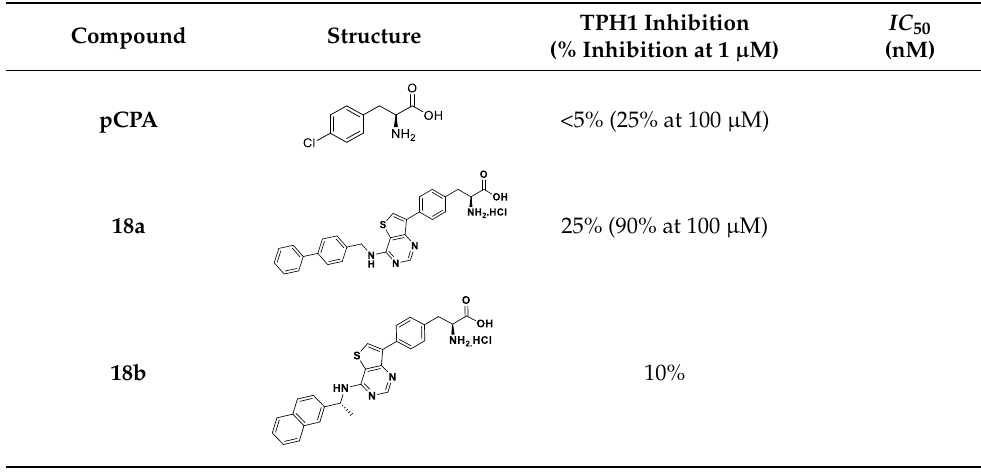
Figure 2. Binding analysis of compound 11b: Predicted binding mode of compound 11b with TPH1. TPH1 is shown as ribbons, while compound 11b is represented by sticks. The inset ( left ) shows the binding of compound 11b to the substrate-binding pocket of TPH1. The zoomed-in view ( right ) highlights the hydrophobic tail of compound 11b binding at the exterior of the active site of TPH1 with weak interactions. The entrance of the active site of TPH1 is not occupied with compound 11b which is required for the effective inhibition of TPH1. Table 2. In vitro test of thienopyrimidine derivatives.